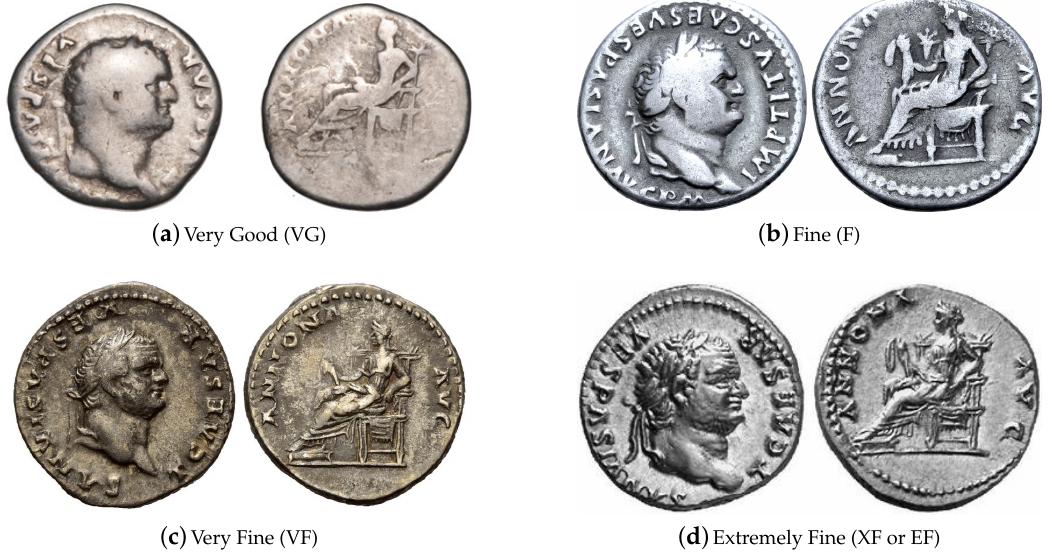
Figure 1. Examples of the same coin issue (denarius of emperor Titus; RIC 972 [Vespasian], RSC 17, BMC 319) in different grades of conservation: ( a ) Very Good (VG), ( b ) Fine (F), ( c ) Very Fine (VF), and ( d ) Extremely Fine (XF or EF). The two lowest grades, namely fair (Fr) and good (G), are not shown due to the lack of interest in specimens damaged so